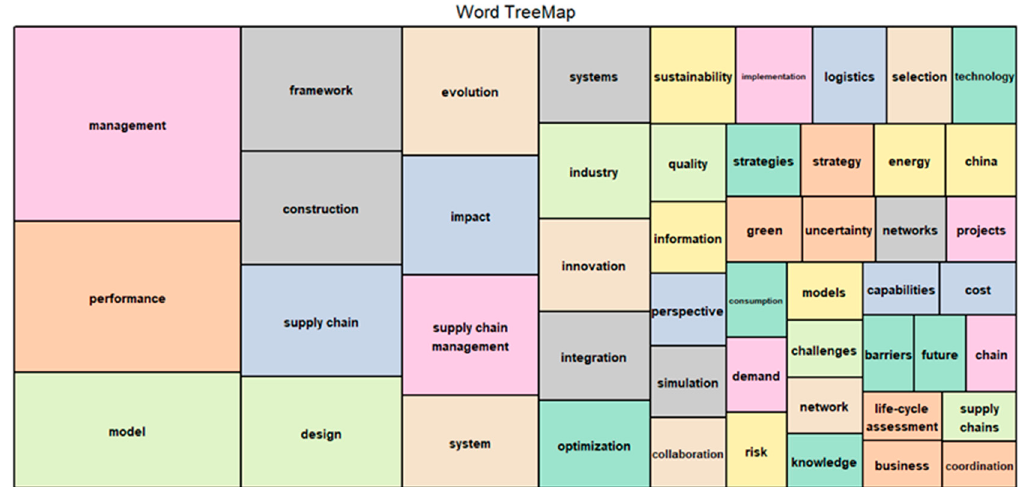
Figure 8 . CSCM’s keyword clouds .